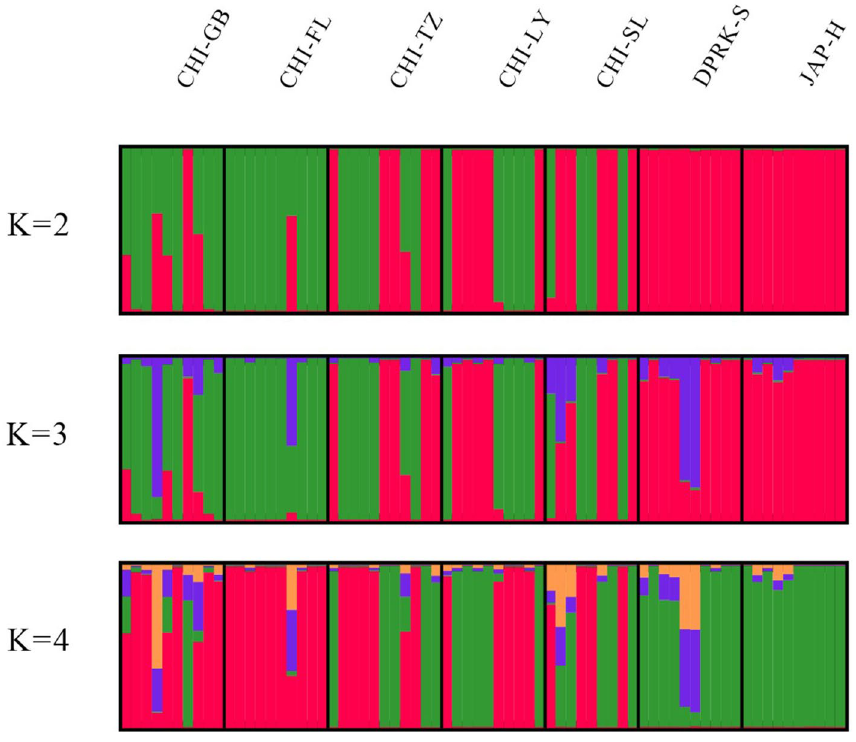
Figure 3. Genetic variability in Manila clam populations. (A) Haplotype diversity (± SD) estimated from the whole set of COI sequences. (B) Nucleotide diversity (± SD) estimated from the whole set of COI sequences.